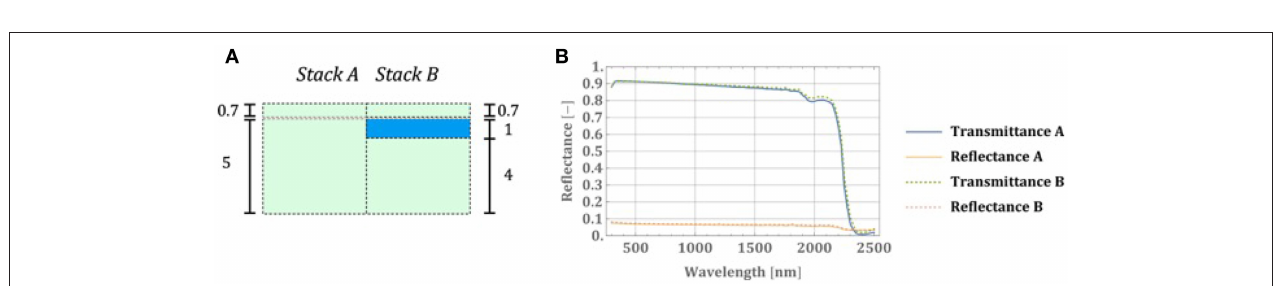
FIGURE 7 | (A) Schematic for stacks A and B, representing the area without and with refrigerant channel. Transmittance and reflectance at normal incidence for stack A and B.